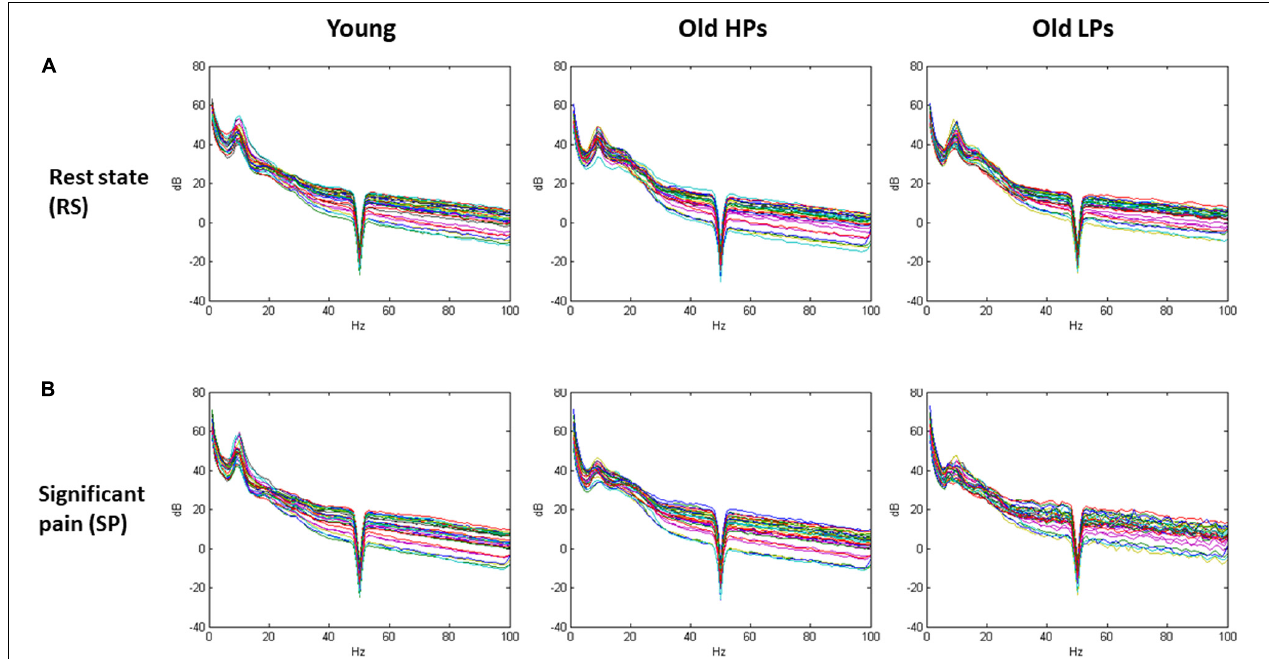
FIGURE 3 | Spectral waveform in the pain-free and significant pain states for each group. (A) Spectral waveform during resting-state and (B) significant pain state.